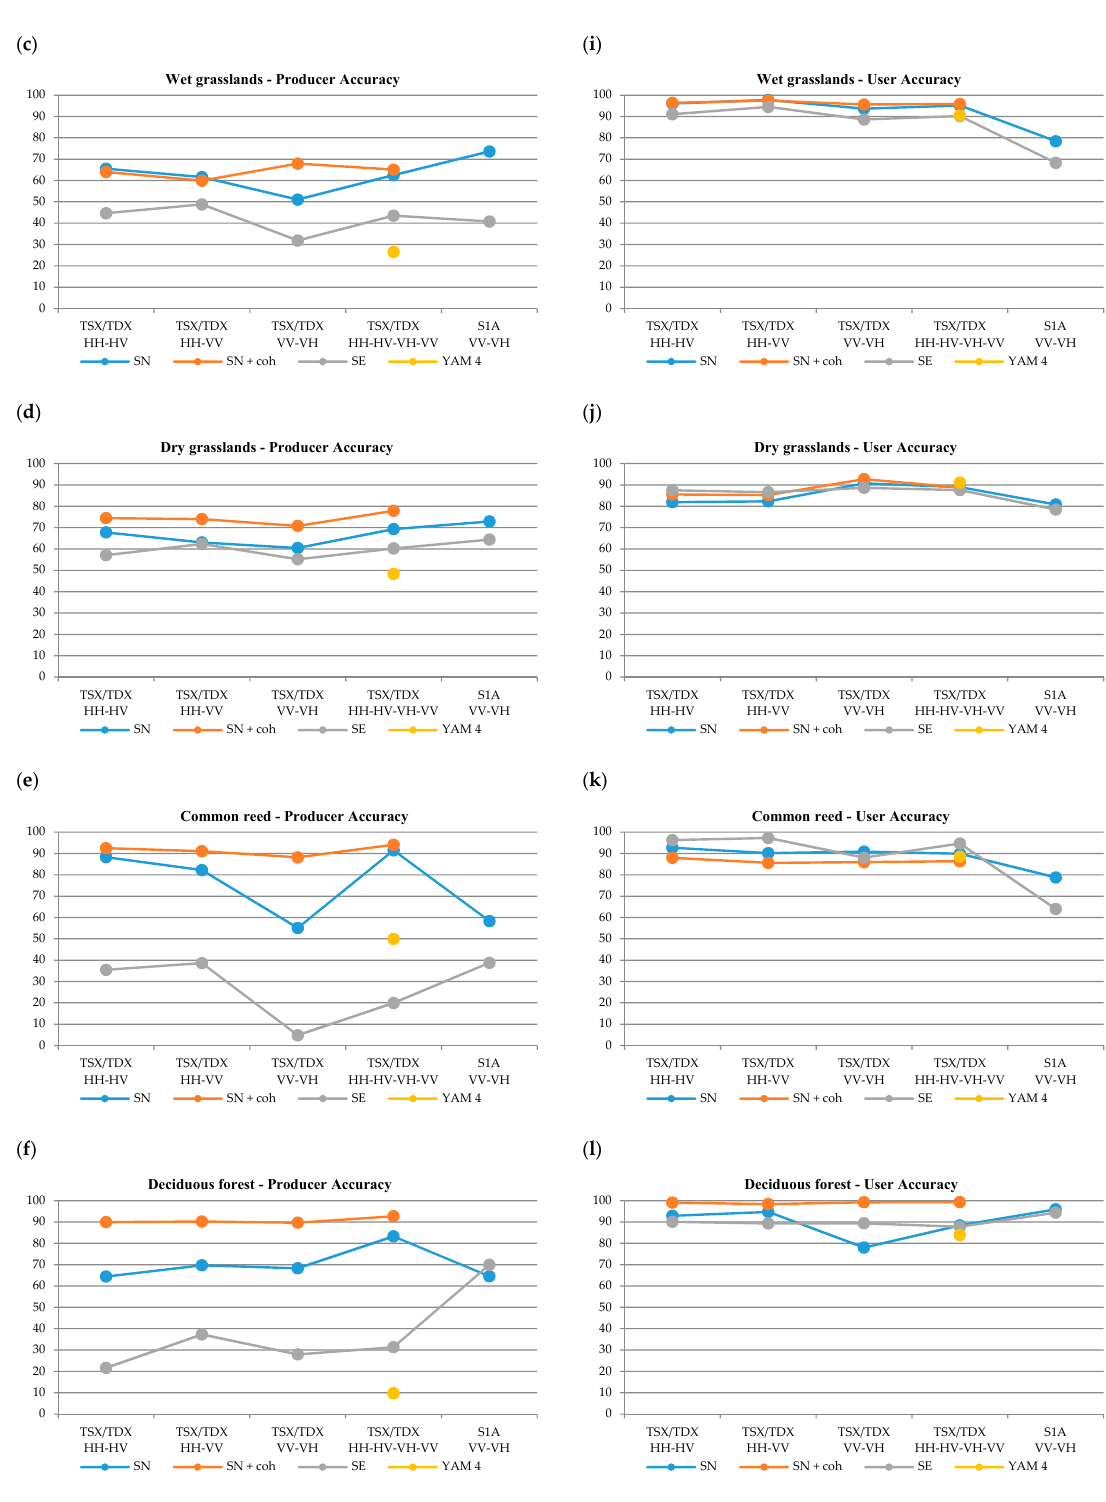
Figure 11. The Producer’s ( a – f ) and User’s Accuracy ( g – l ) extracted from the confusion matrices for the final six classes, calculated for four data subsets.